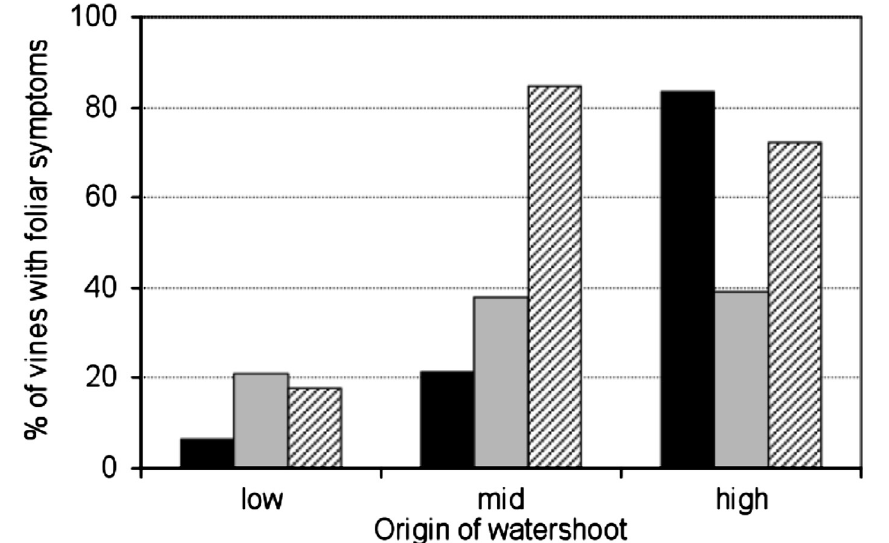
Figure 2. Incidence of foliar symptom recurrence on shoots of ‘Shiraz’ vines which originated from low (bottom third of trunk), mid (middle third) and high (top third) positions on the trunk, 6 years after remedial surgery using the high-cut method. Trial 3 (black) and Trial 4 (grey) were located in Coonawarra and Trial 6 (diagonal pattern) in Eden Valley, South